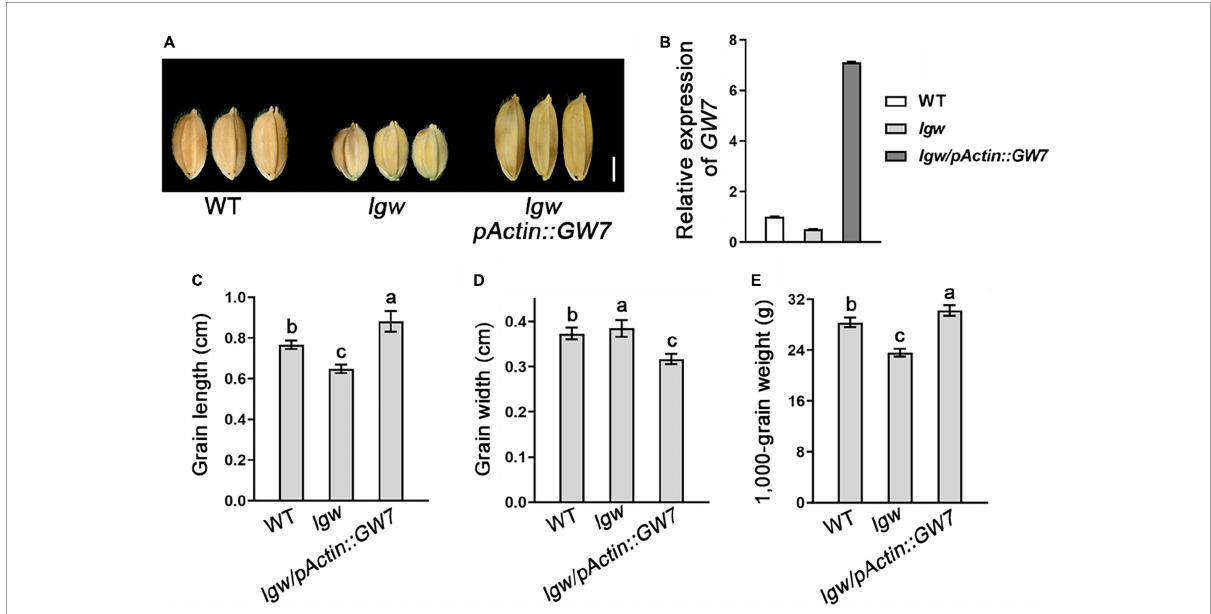
FIGURE7 Elevating GW7 expression level in lgw plants can rescue the small grain size phenotype. (A) Grain shape observation of WT, lgw, and lgw/pActin:GW7 . Bar = 0.3 cm. (B) Expression level of GW7 in WT, lgw, and lgw/pActin:GW7 . (C) Grain length. (D) Grain length. (E) 1,000-Grain weight. Different letters denote significant differences ( P < 0.05) from Duncan’s multiple range